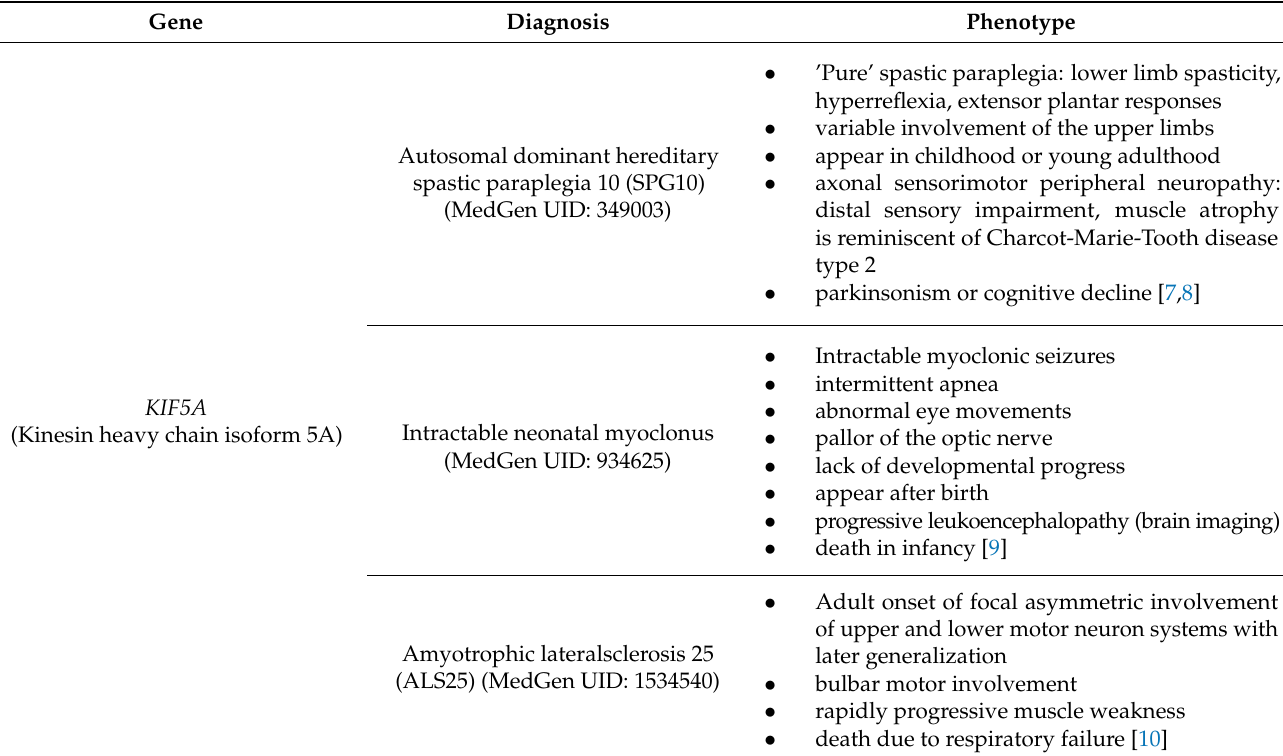
Table 2. Phenotypes of the detected